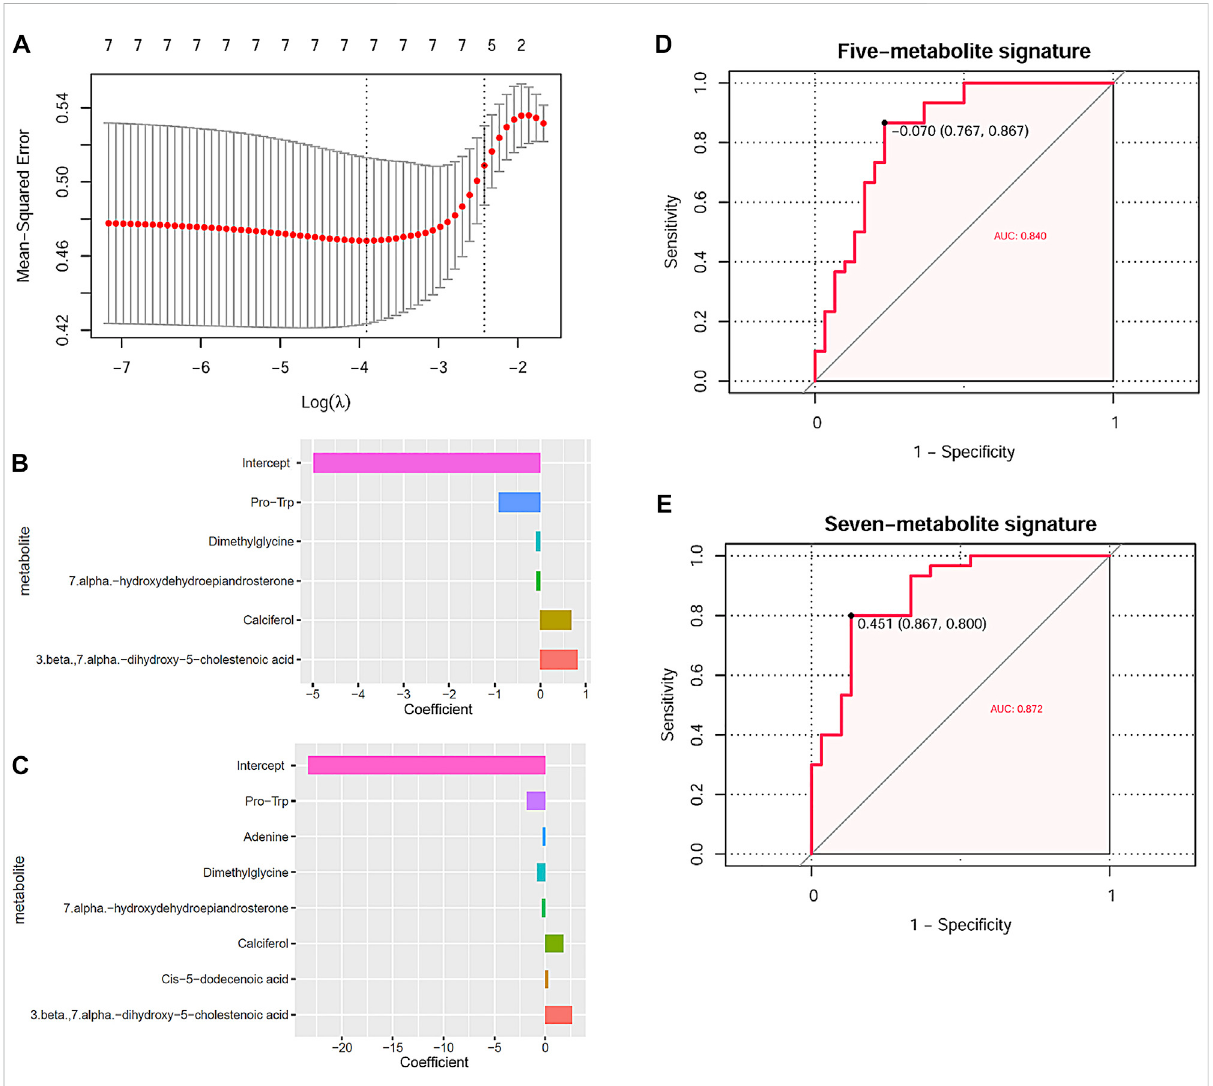
FIGURE 6 NIHL risk model construction through LASSO analysis and their diagnostic power. (A) Tuning parameter lambda ( λ ) selection using 10-fold cross-validation. (B,C) Five and seven DMs-NIHL with the absolute value of the coef fi cients > 0 were included in the LASSO regression models. The x -axis represented the coef fi cients of the metabolites, and the y -axis indicated the metabolite variables. (D,E) LASSO regression models could predicatethehearinglossstatuseffectivelythroughROCcurveanalysis.NIHL,noise-inducedhearingloss;LASSO,leastabsoluteshrinkageand selection operator; ROC, receiver operating characteristics; AUC, area under the